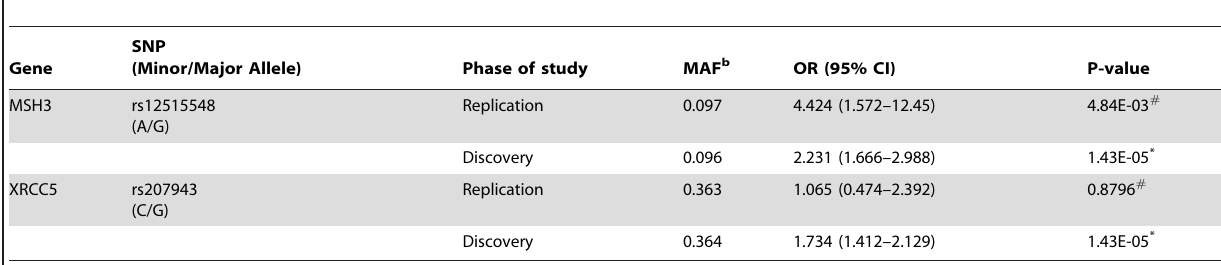
Table 5. Allelic association results of replication study and comparison with discovery data.